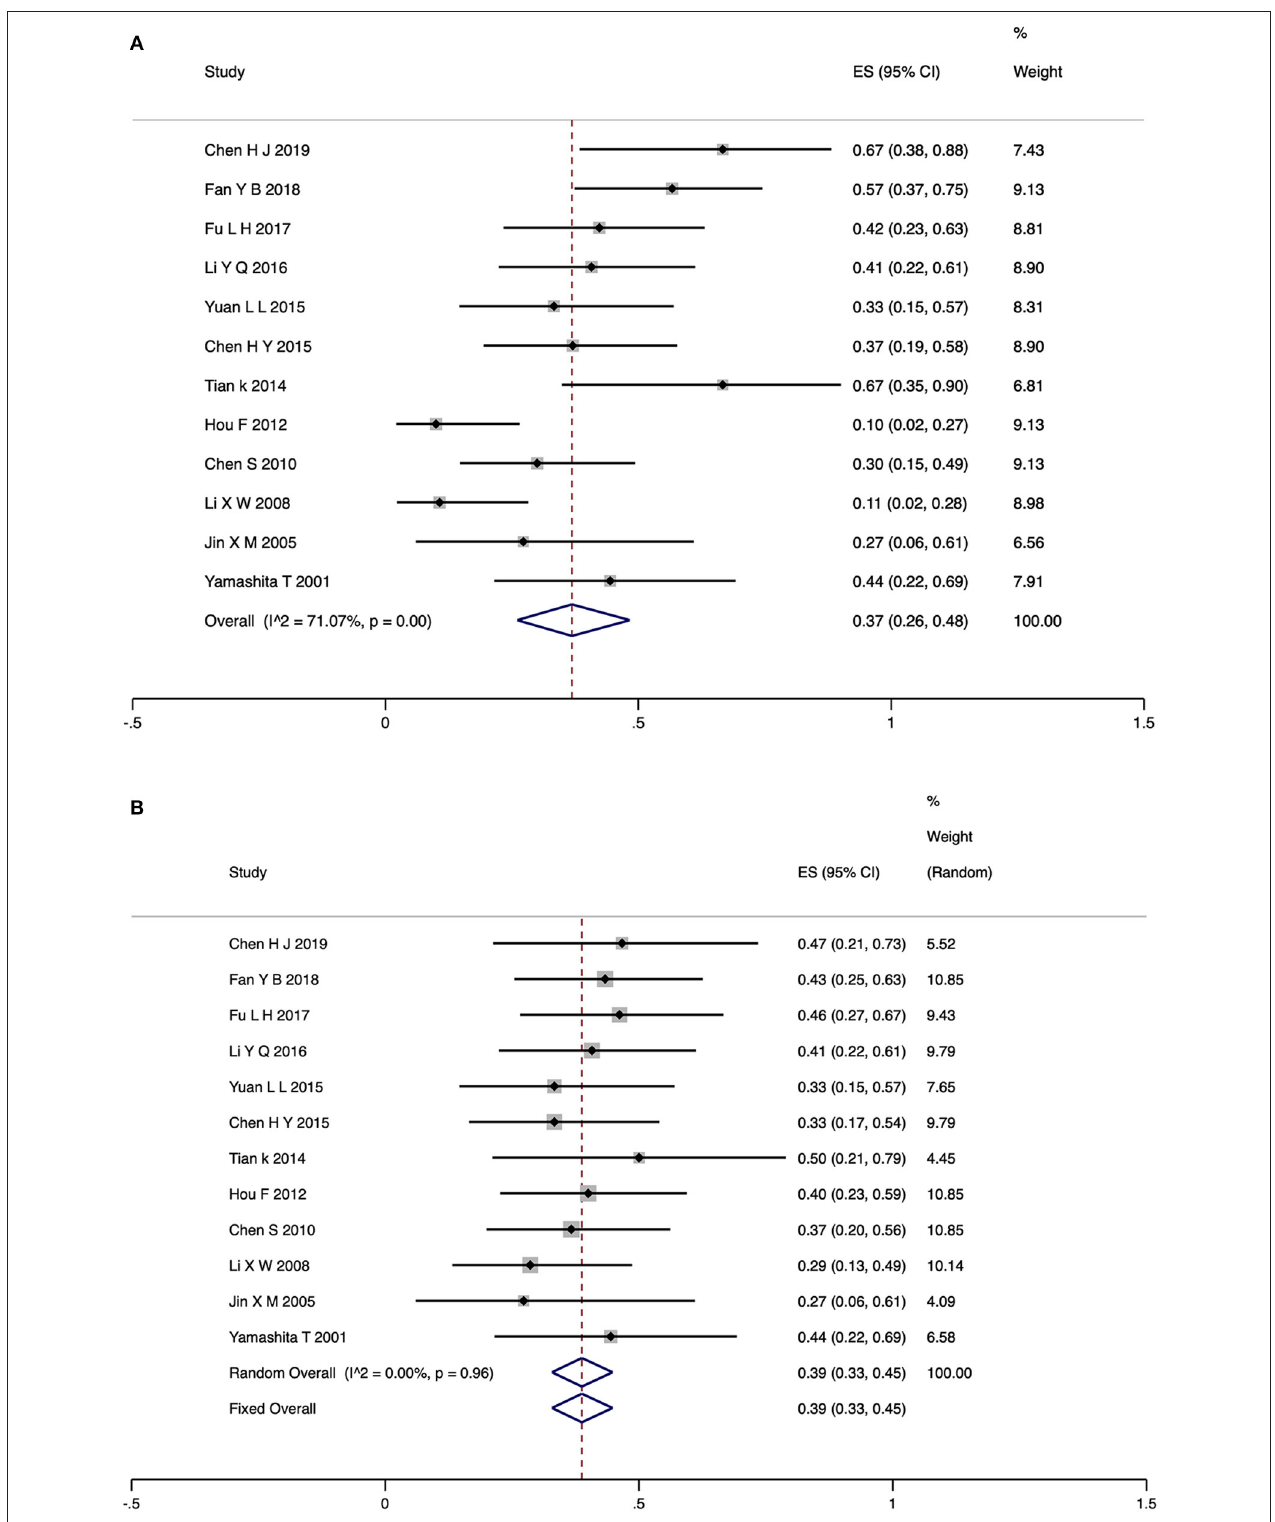
FIGURE 3 | Forest plot for TMH closure rate (A) and VA improvement rate (B) of observation group patients. TMH, traumatic macular hole; VA, visual acuity.